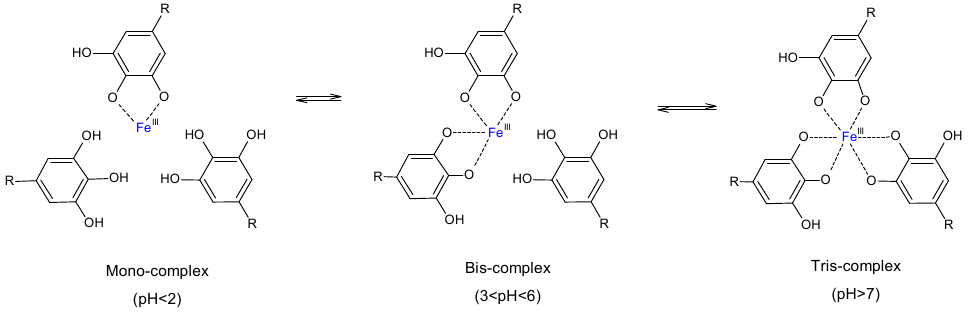
Figure 1. Schematic pH-responsive transition of the TA-Fe +++ complex state.